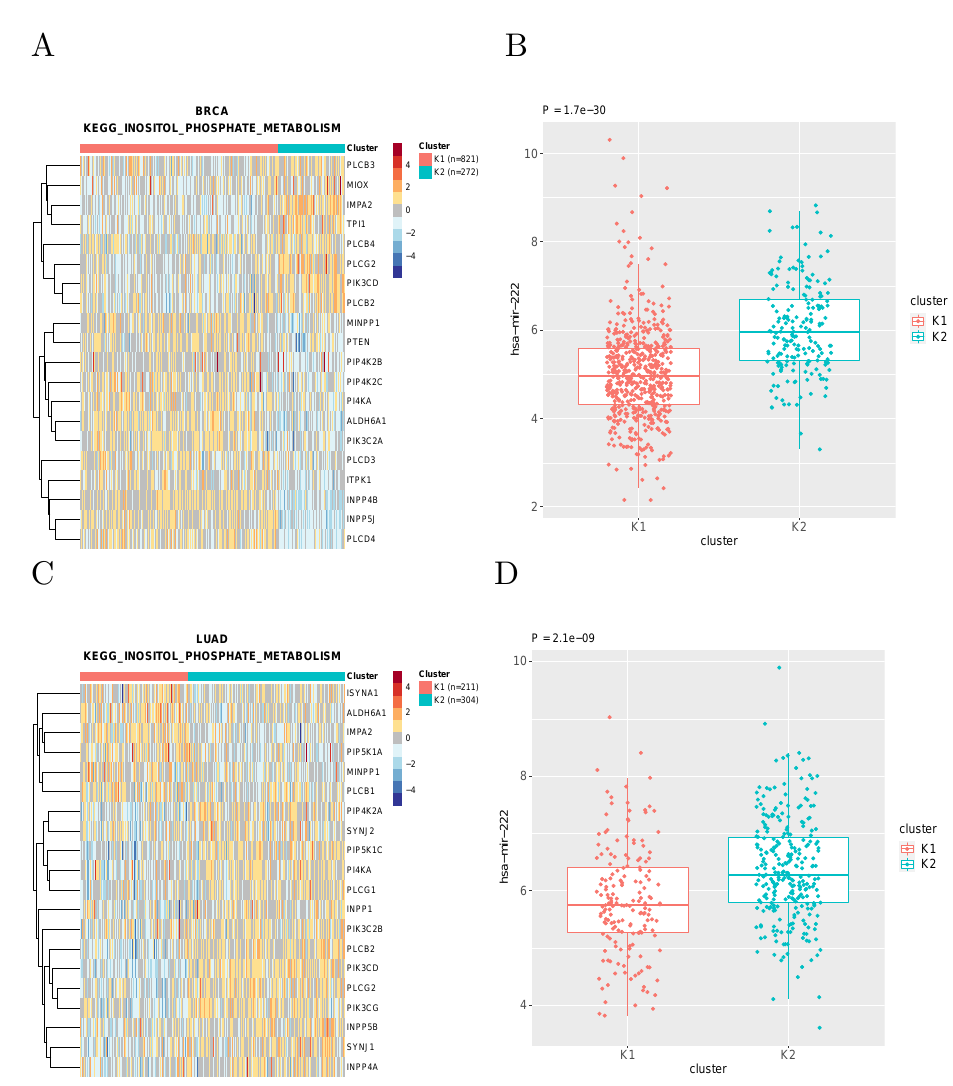
Figure 4. ( A ) Clustering of breast cancer samples using the genes associated to inositol phosphate metabolism according to KEGG. ( B ) Expression of miR-222 in the two clusters. ( C , D ) Same for lung adenocarcinoma